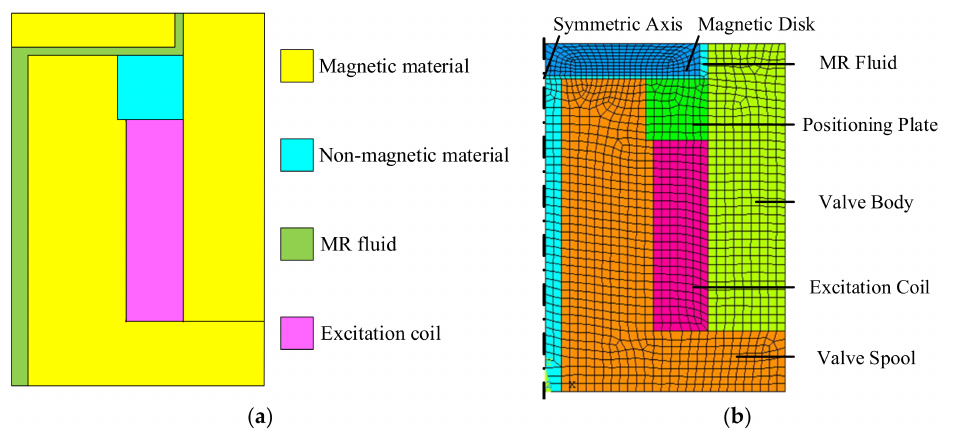
Figure 4. 2D finite element model of the MR valve: ( a ) geometric model, ( b ) meshed